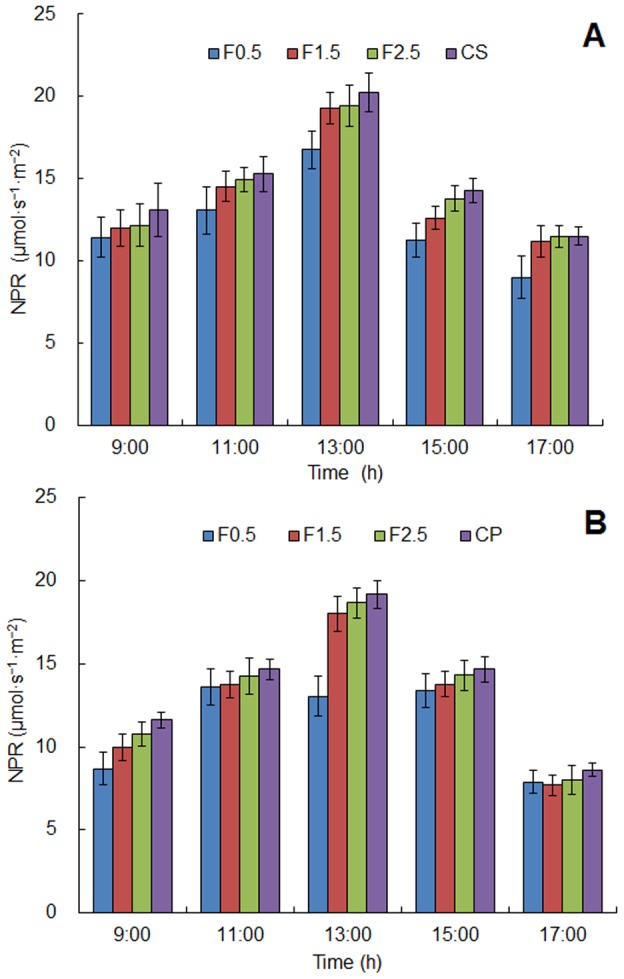
Diurnal variation of net photosynthetic rate (NPR) for the intercropping systems and its control (A. apple–soybean and B. apple–peanut).F0.5, F1.5 and F2.5 were used to represent the sampling points which had different distance (0.5 m, 1.5 m and 2.5 m) from the tree row. Error bars indicate standard deviation.